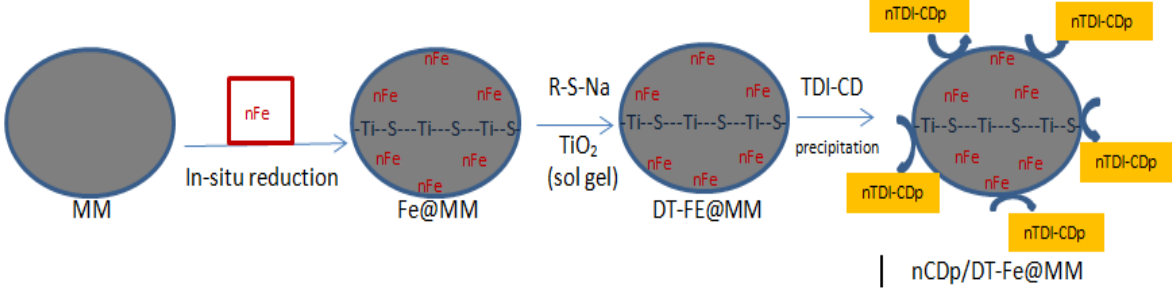
Figure 1. Schematic representation of the preparation steps of the tripartite magnetic montmorillonite composite.